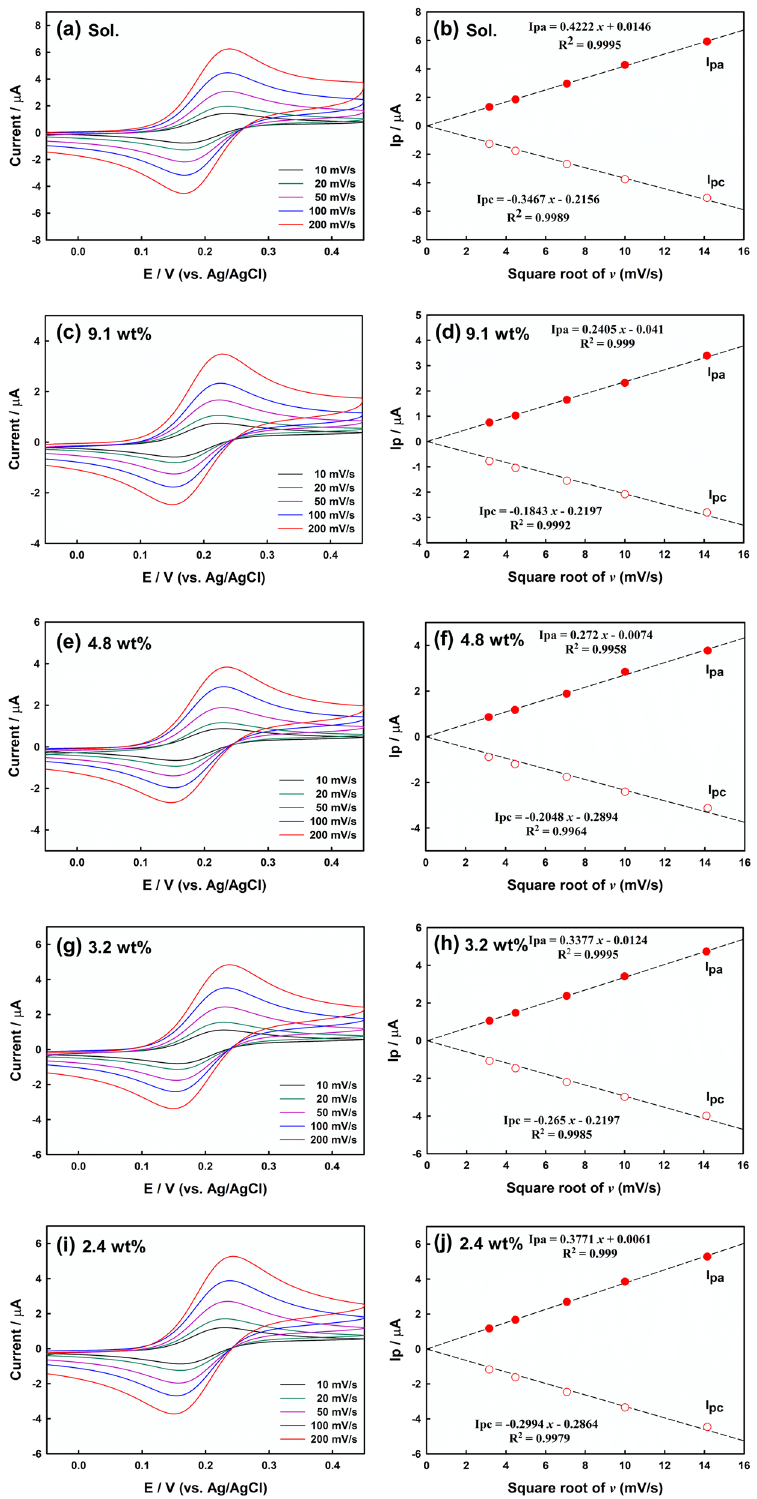
Fig. 1 CV curves of the Au disk electrode in aqueous solution and at various concentrations of agarose hydrogels, and plots of the peak current ( I p ) as a function of the square root of the scan rate b , d , f , h , i containing 1 mM Fe(CN) 64– and 0.1 M KCl. a and b In solution phase; c and d 9.1 wt% agarose; e and f 4.8 wt% agarose; g and h 3.2 wt% agarose; and i and j 2.4 wt%